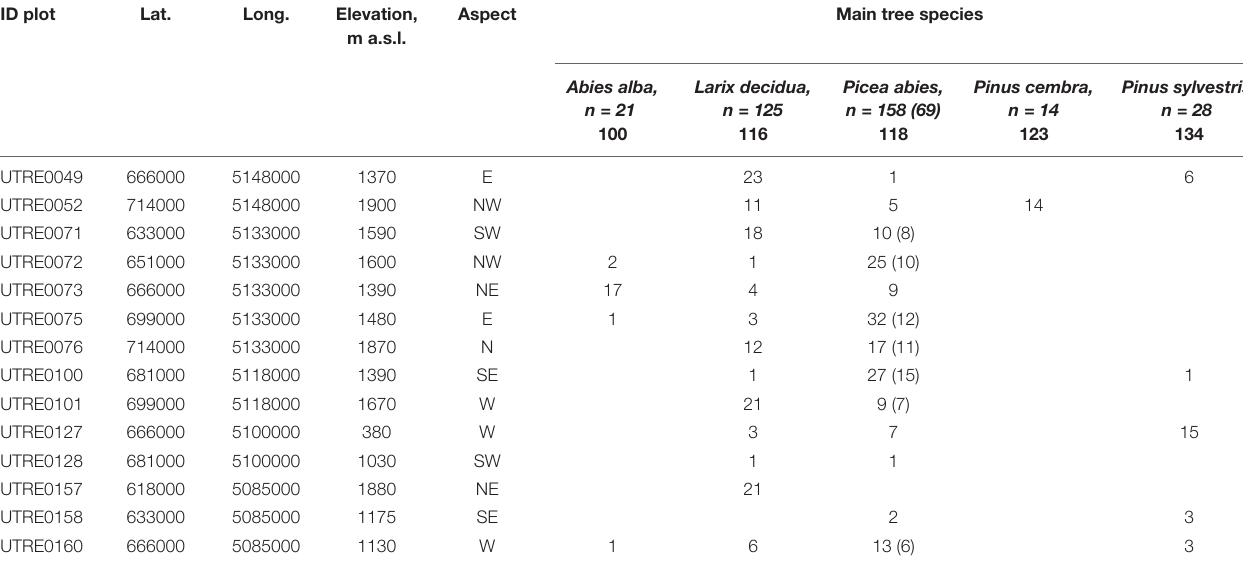
TABLE 1 | Plot data and number of trees for each species considered for crown condition and periodical growth. ID plot Lat. Long. Elevation, m a.s.l.